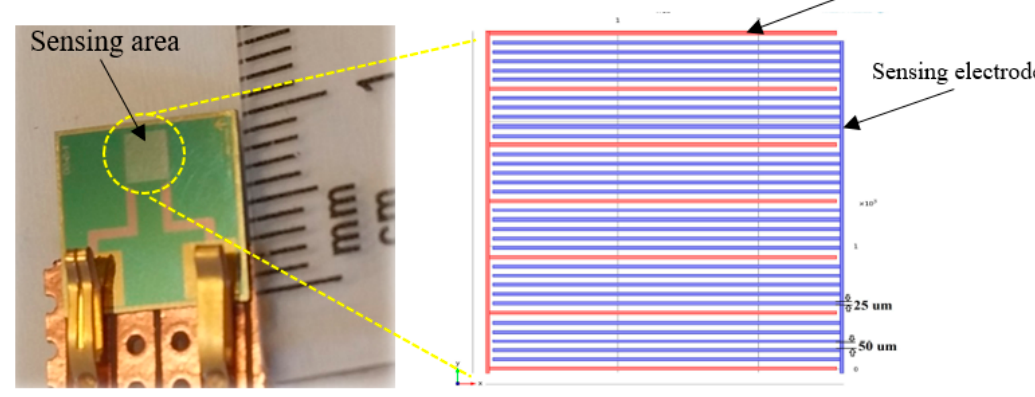
Figure 4. Planar interdigital sensor with multi-sensing electrode configuration.